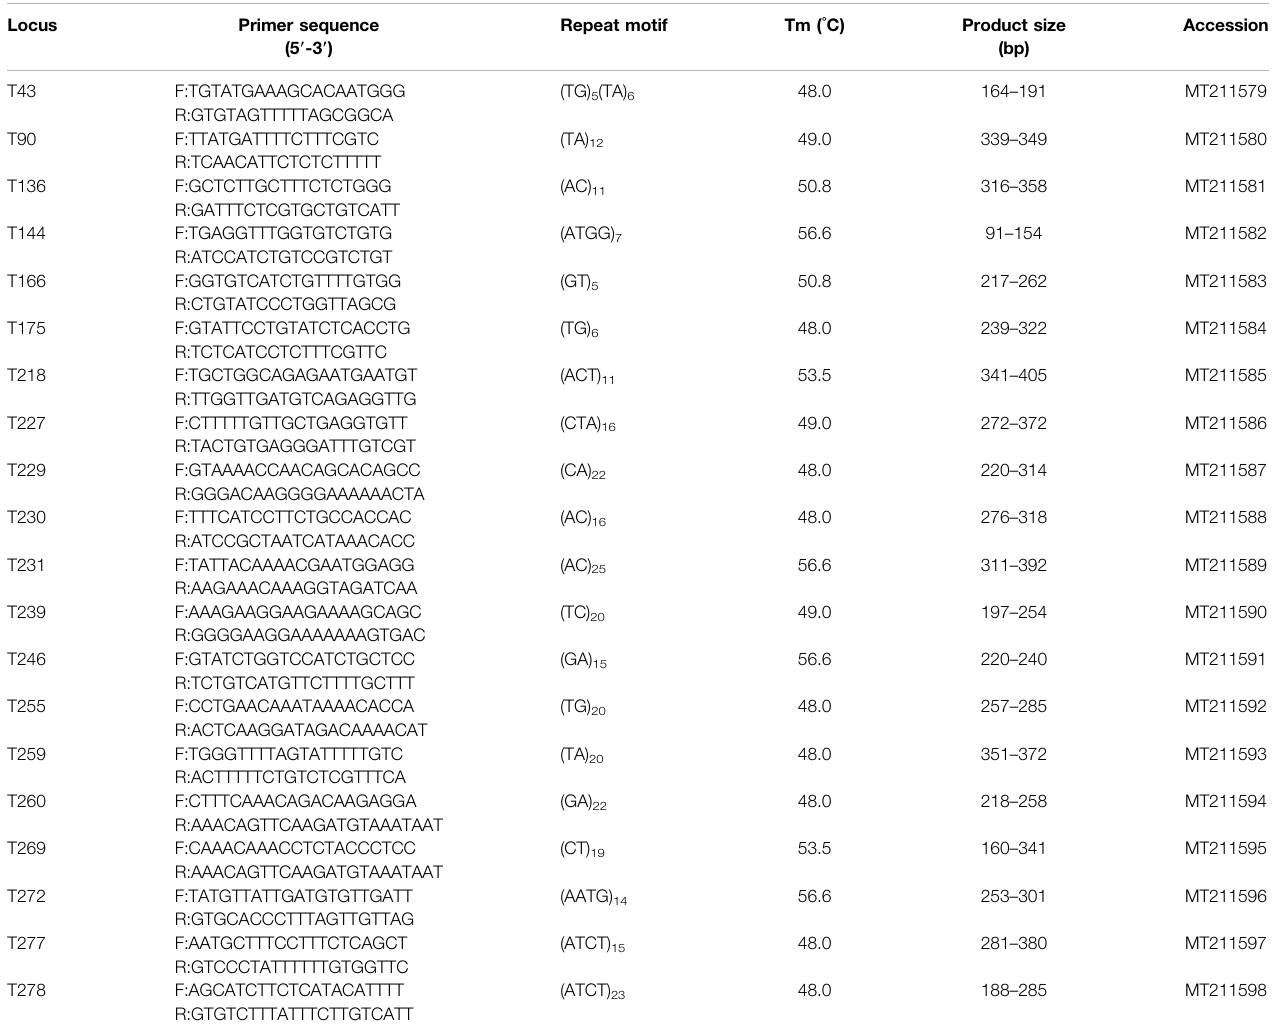
TABLE 1 | 20 microsatellite locus characteristics of Schizothorax biddulphi .